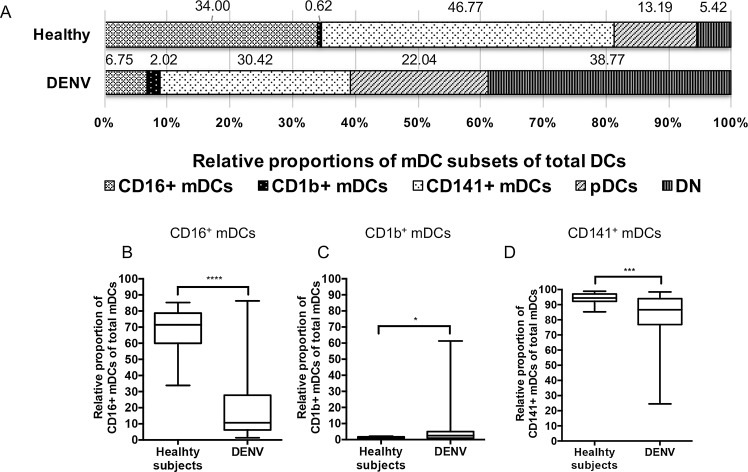
Comparison of the relative proportion of mDC subsets in DENV infected patients.Distribution of each of the three mDC subsets as a percentage of total DCs during acute DENV was analyzed from 64 DENV-infected samples and 14 healthy subjects (A). The relative proportion (%) of CD16+ mDCs (B), CD1b+ mDCs (C) and CD141+ mDCs (D) as a percentage of total mDCs in DENV-infected patients were compared with those of healthy subjects. The box plot shows the median value (horizontal line in the box). The box and whisker represent 25th to 75th, and 10th to 90th interquartile range, respectively. P values were determined by the Mann-Whitney U test for comparison between two groups. (* p < 0.05, *** p <0.001 and **** p < 0.0001).